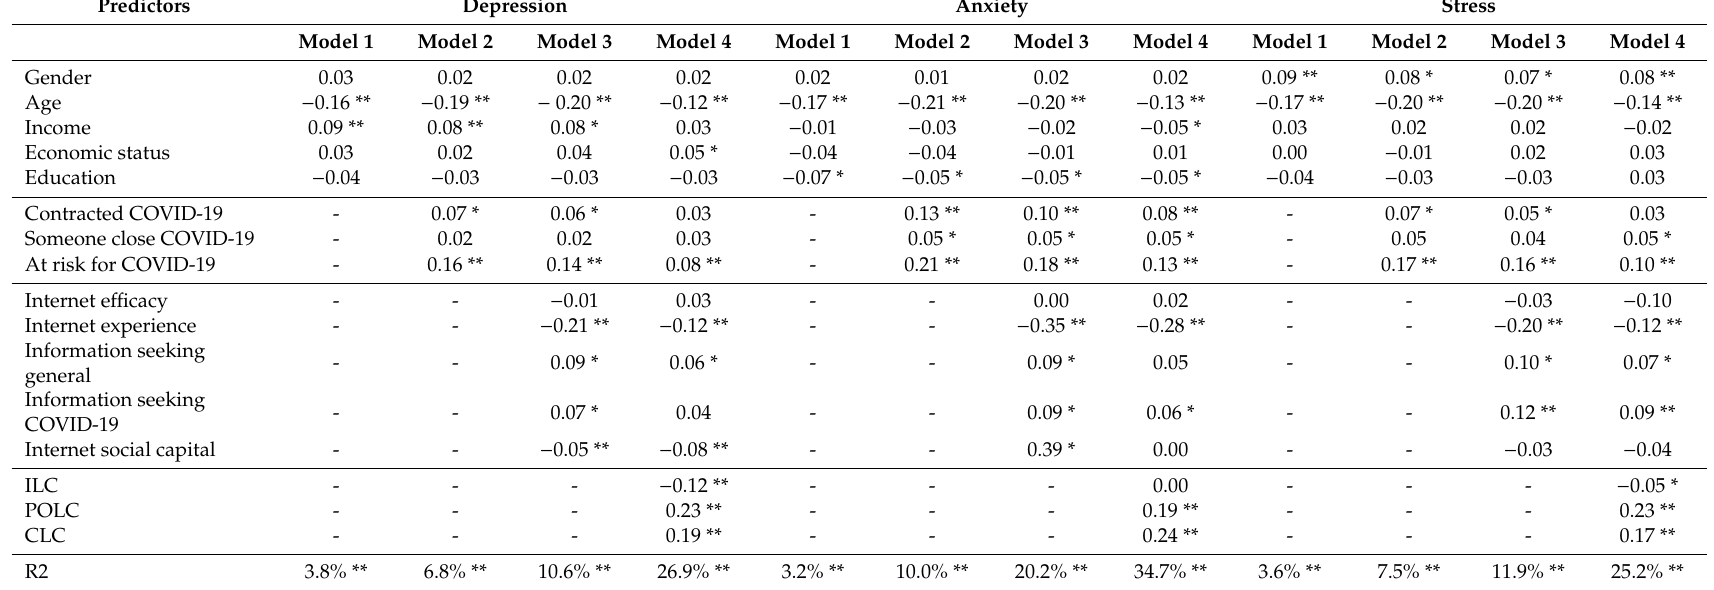
Table 3. Multiple linear regression predicting depression, anxiety and stress symptoms, showing standardized coe ffi